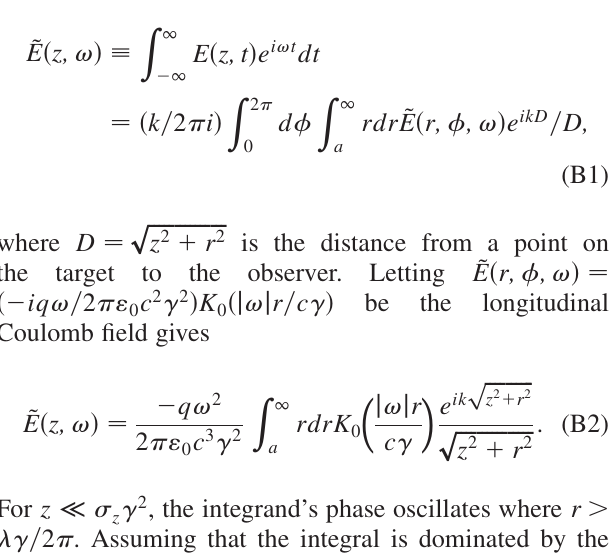
p ffiffiffiffiffiffiffiffiffiffiffiffiffiffiffiffi p ffiffiffiffiffiffiffiffiffiffiffiffiffiffiffi z 2 þ a 2 z 2 þ r 2 ffiffiffiffiffiffiffiffiffiffi p z 2 þ a 2 rdrK ffiffiffiffiffiffiffiffiffiffiffiffiffiffiffiffi p z 2 þ a 2 a